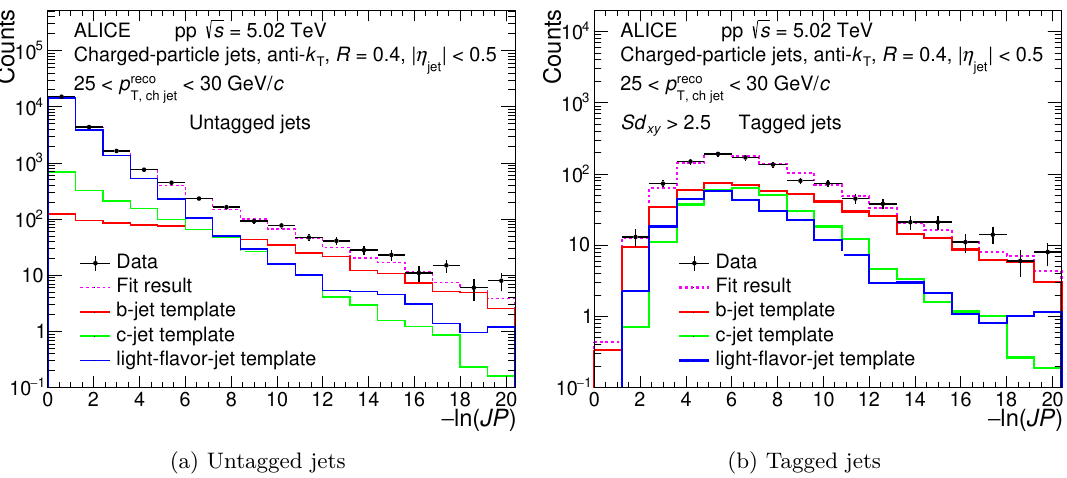
Figure 5. Fit of the measured − ln( JP ) discriminator distribution with a linear combination of b, c, and light-flavor jet templates for the untagged sample (left) and for the tagged sample (right). Two jet samples were created: a sample that contains the jets satisfying the tagging requirement (tagged sample), and another sample that contains the inclusive jets before applying the tagging algorithm (untagged sample). The associated − ln( JP ) distributions from data were fitted with the corresponding b, c, and light-flavor jet templates using